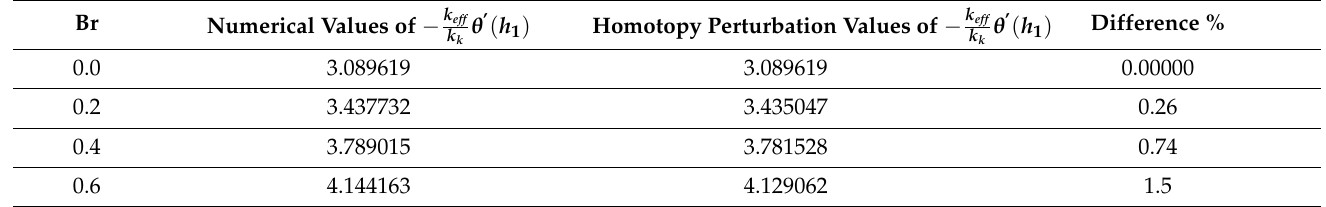
Table 4. Heat transfer rate at the upper boundary by changing Brinkman number, where γ = π α = π , η = 0.8, a = 0.6, d = 0.7, b = 0.5, x = 0, k = 2, m = 1, Gr = 2, M = 1, ∈ = 2, φ = 4